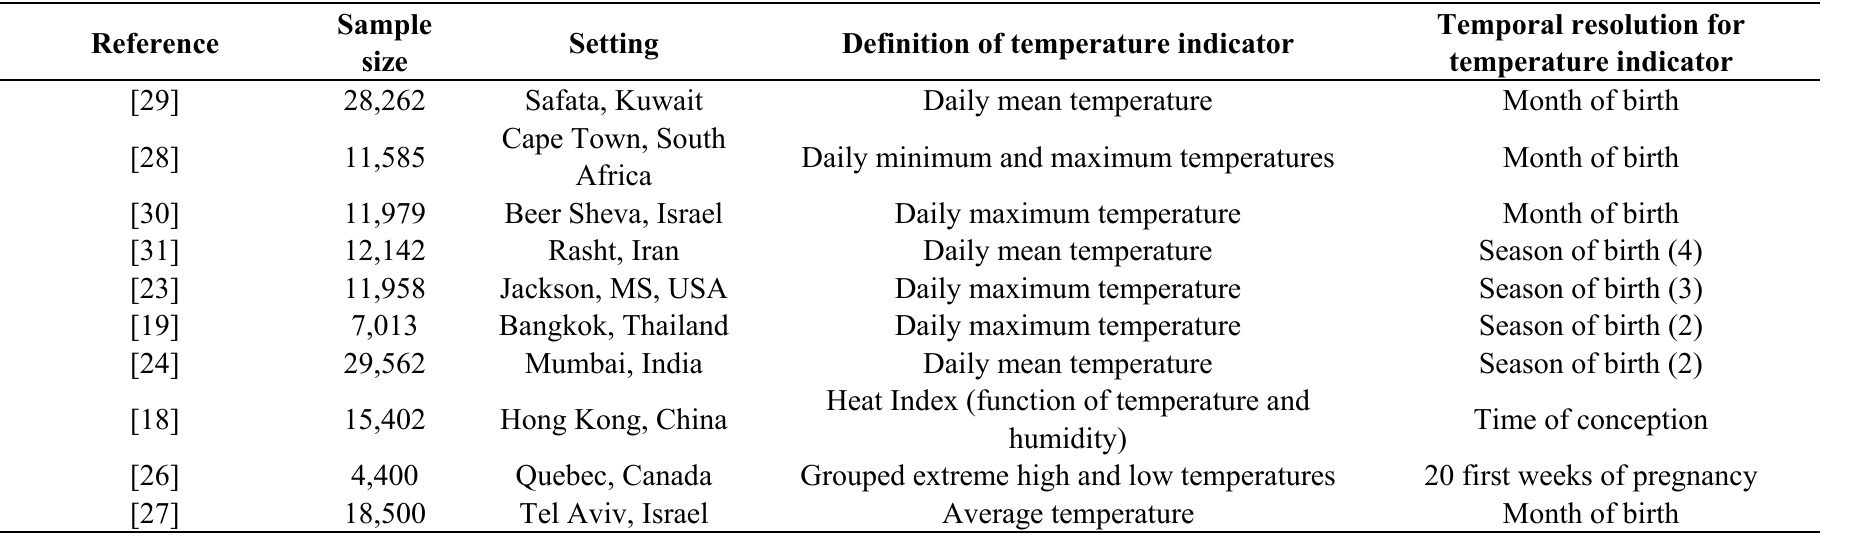
Table A8. Studies examined for the meta analysis of the association between temperature and preeclampsia